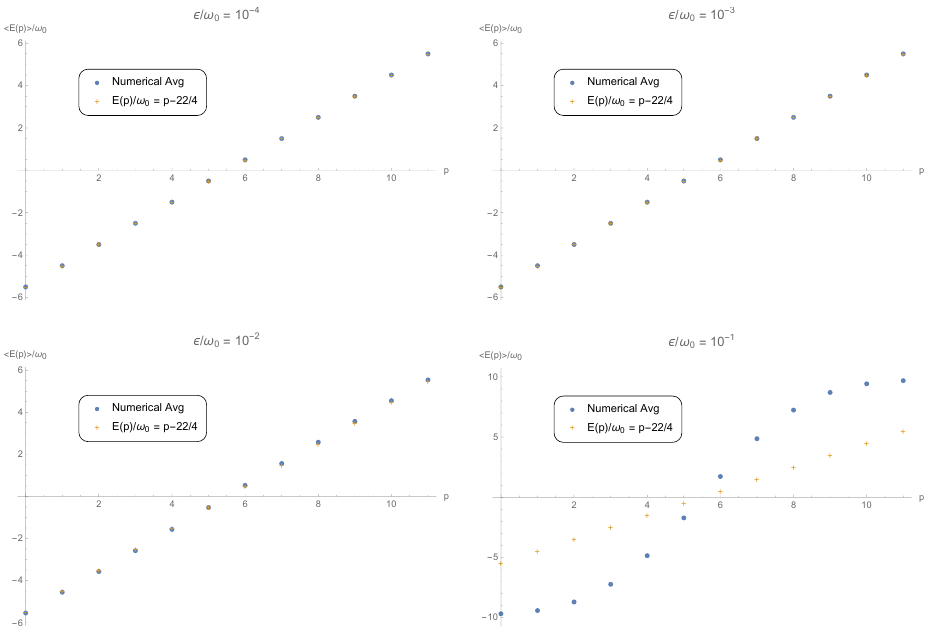
Figure 21 . Above are plots of the average energy within degenerate sectors labelled by p at various coupling regimes ranging from the weakly coupled regime with (cid:15)/ω 0 = 10 − 4 to the strongly coupled regime with (cid:15)/ω 0 = 10 − 1 . The solid circles are numerical computations of the average and the “ + ” is the energy of the degeneracy sector in the free oscillator